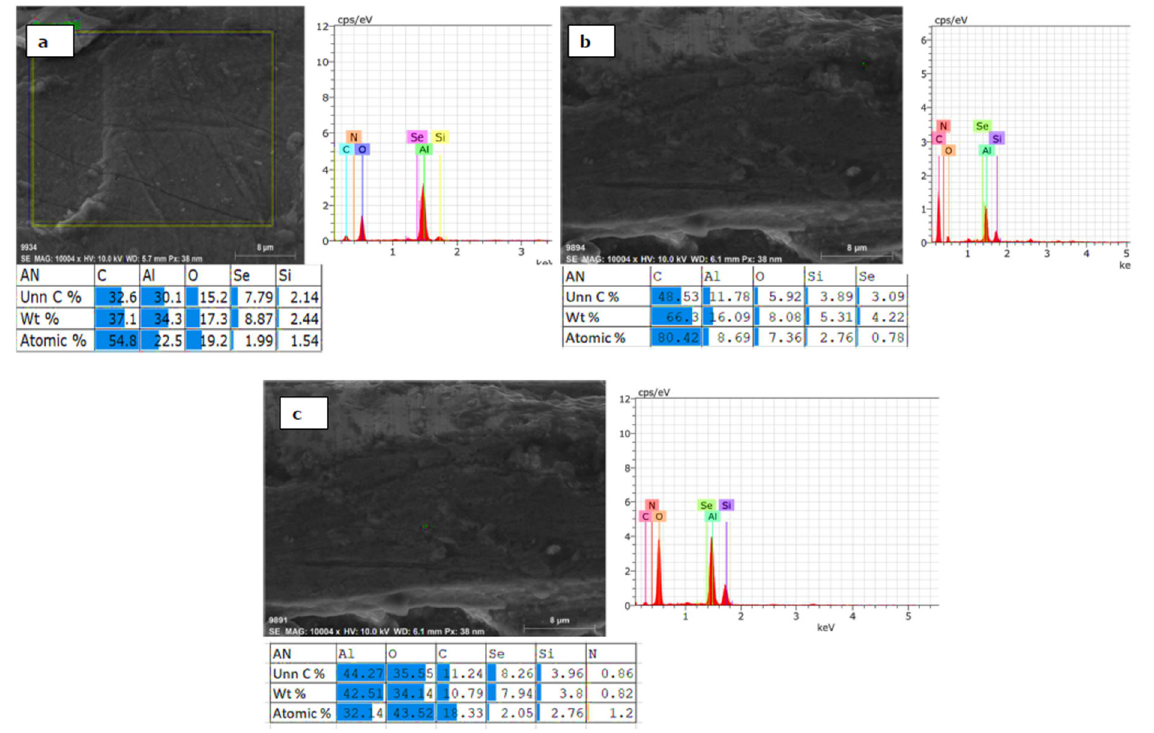
Figure 8. EDX images for samples ( a ) At 197 V and 0.3 A, ( b ) At 197 V and 0.5 A, ( c ) At 197 V and 1 A.